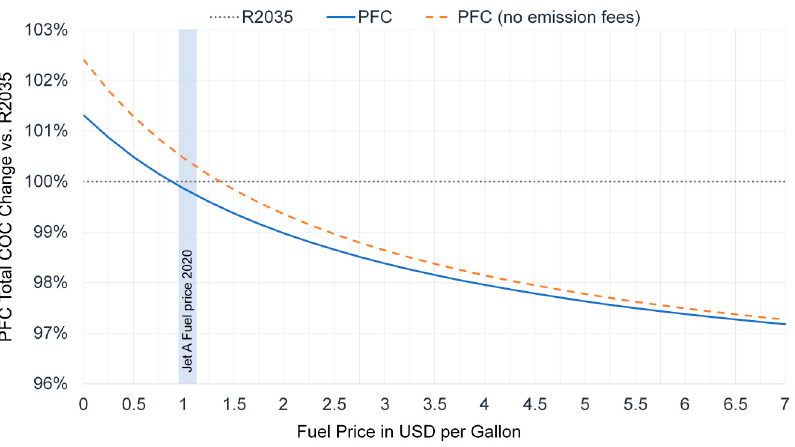
Figure 40. Fuel price study of CENTRELINE PFC versus R2035 design mission COC (adapted from [111]).